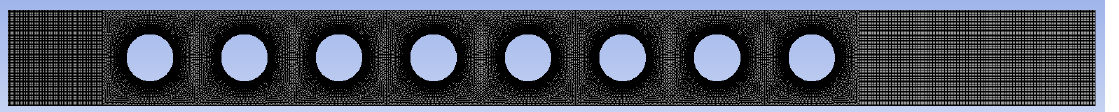
Figure 2. Overall mesh generation for a 1.6 × 1.6 pitch ratio.